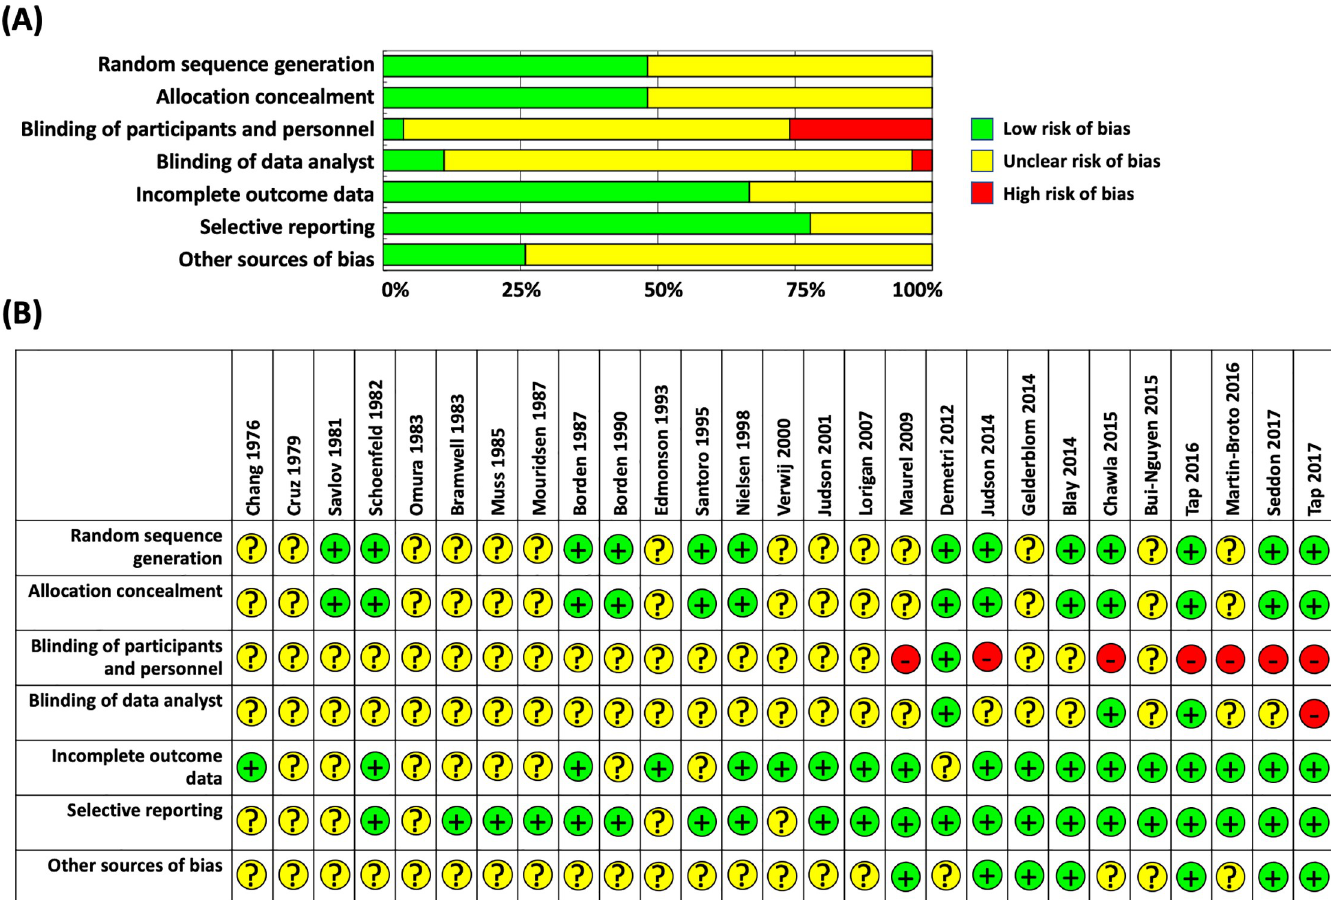
PLOS ONE | https://doi.org/10.1371/journal.pone.0210671 January 10,